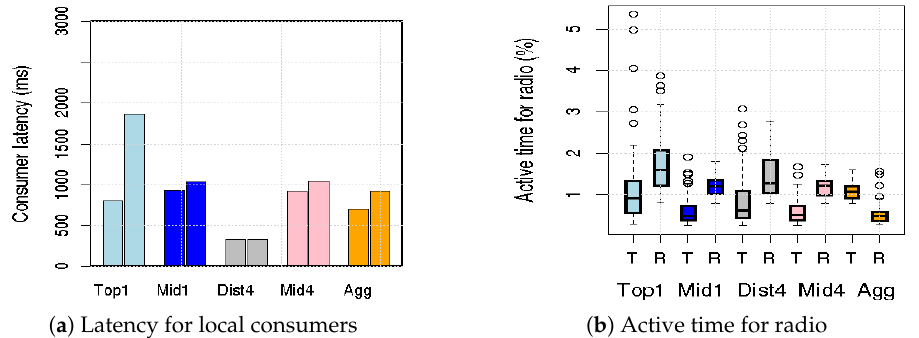
Figure 9. Metrics for the communication models. ( a ) Time to reach local consumers. ( b ) Percentage of time when radio was